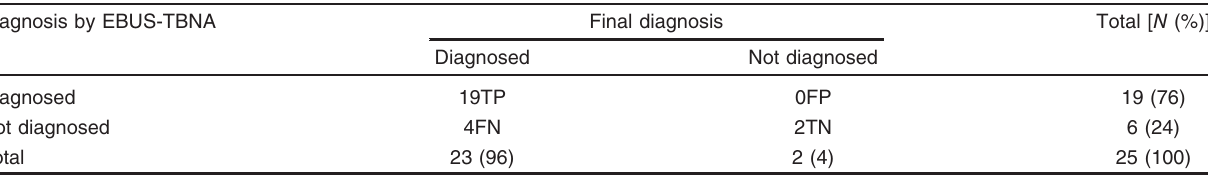
Table 5 Overall detection rate (diagnostic yield) of endobronchial ultrasound-transbronchial needle aspiration in diagnosis Diagnosis by EBUS-TBNA